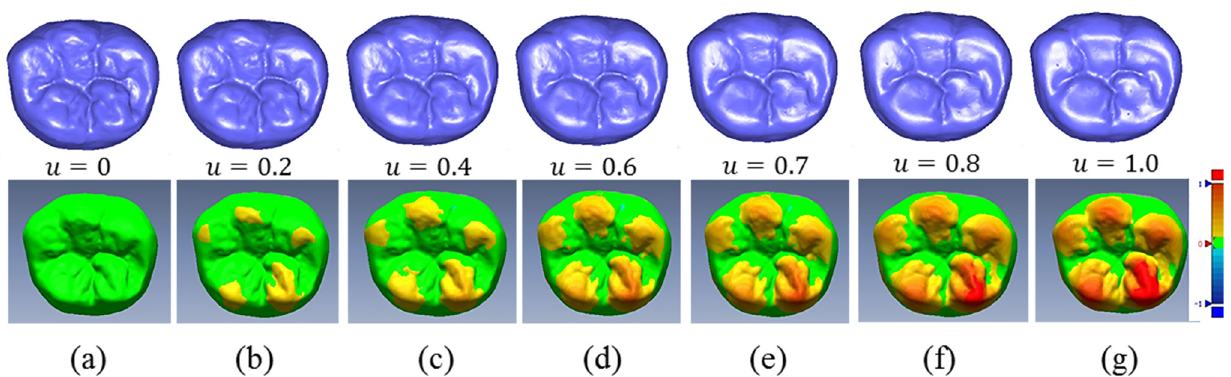
Fig 5. Linear attrition process simulation for the mandibular first molar attrition. a. tooth surface before attrition; b-f. tooth wear surface with parameter u from 0.2 to 0.8; g. tooth wear surface with parameter u = 1.0. The color from yellow to red shows the distribution area and degree of wear.